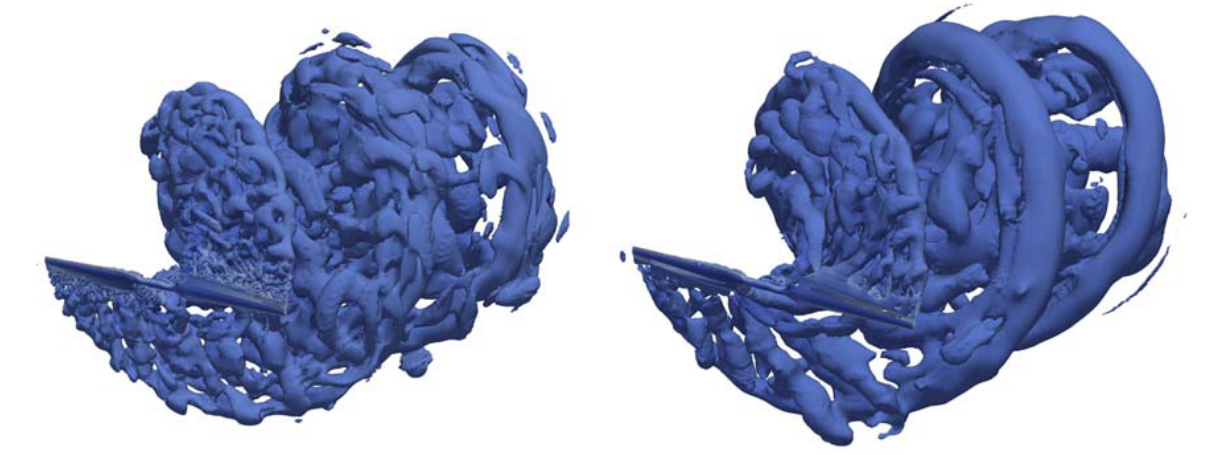
Figure 17. Vorticity contours when wind speed = 15 m/s and time = 1.2 s ( left : VLES; right : URANS).